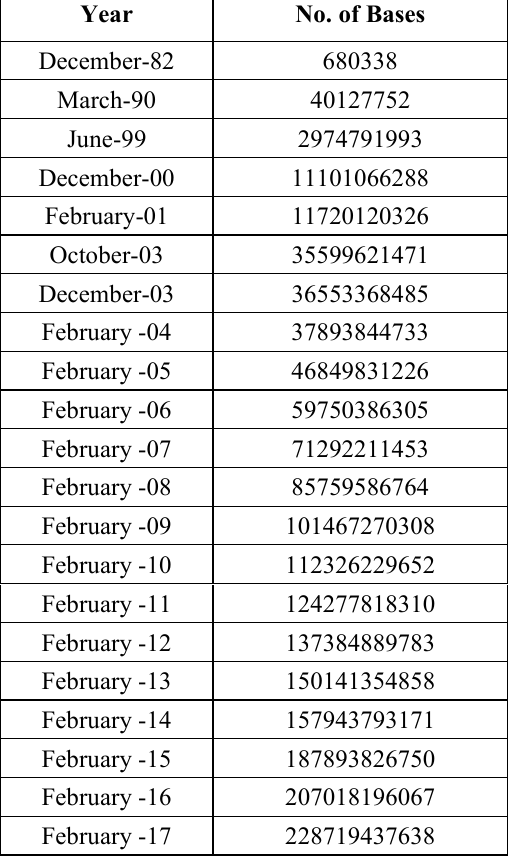
Figure 1. The Exponential Growth Of Genetic Bases in the Genbank Database Source -http://www.ncbi.nlm.nih.gov/genbank/statistics Table 1. The Exponential Growth of Genetic Bases in the GenBank Database Source